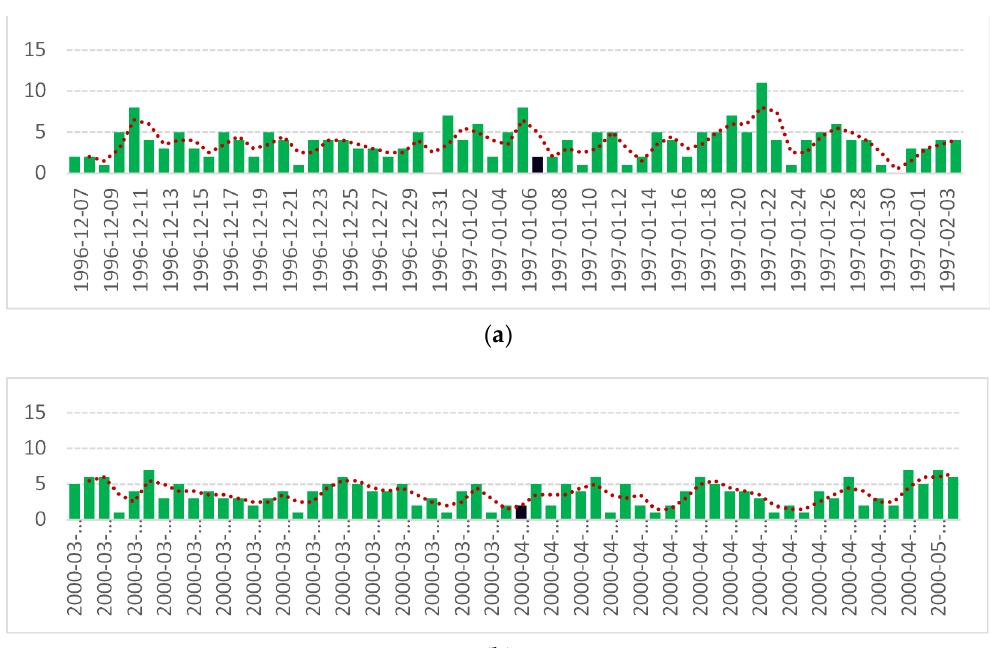
Figure 2. Daily numbers of deaths from diseases of the circulatory system (I00–I99) during exceptionally strong solar events in period of years 1994–2015. ( a ) Geomagnetic storm on 7 January 1997, ( b ) X20 class storm on 2 April 2000, ( c ) class X5 storm on 14 July 2000, Bastille Day Event, ( d ) class X17 storm on 28 October 2003, Halloween Solar Storms, ( e ) class X1 storm on 7 September 2005, and ( f ) class G4 storm on 17 March 2015, St. Patrick’s Day event.